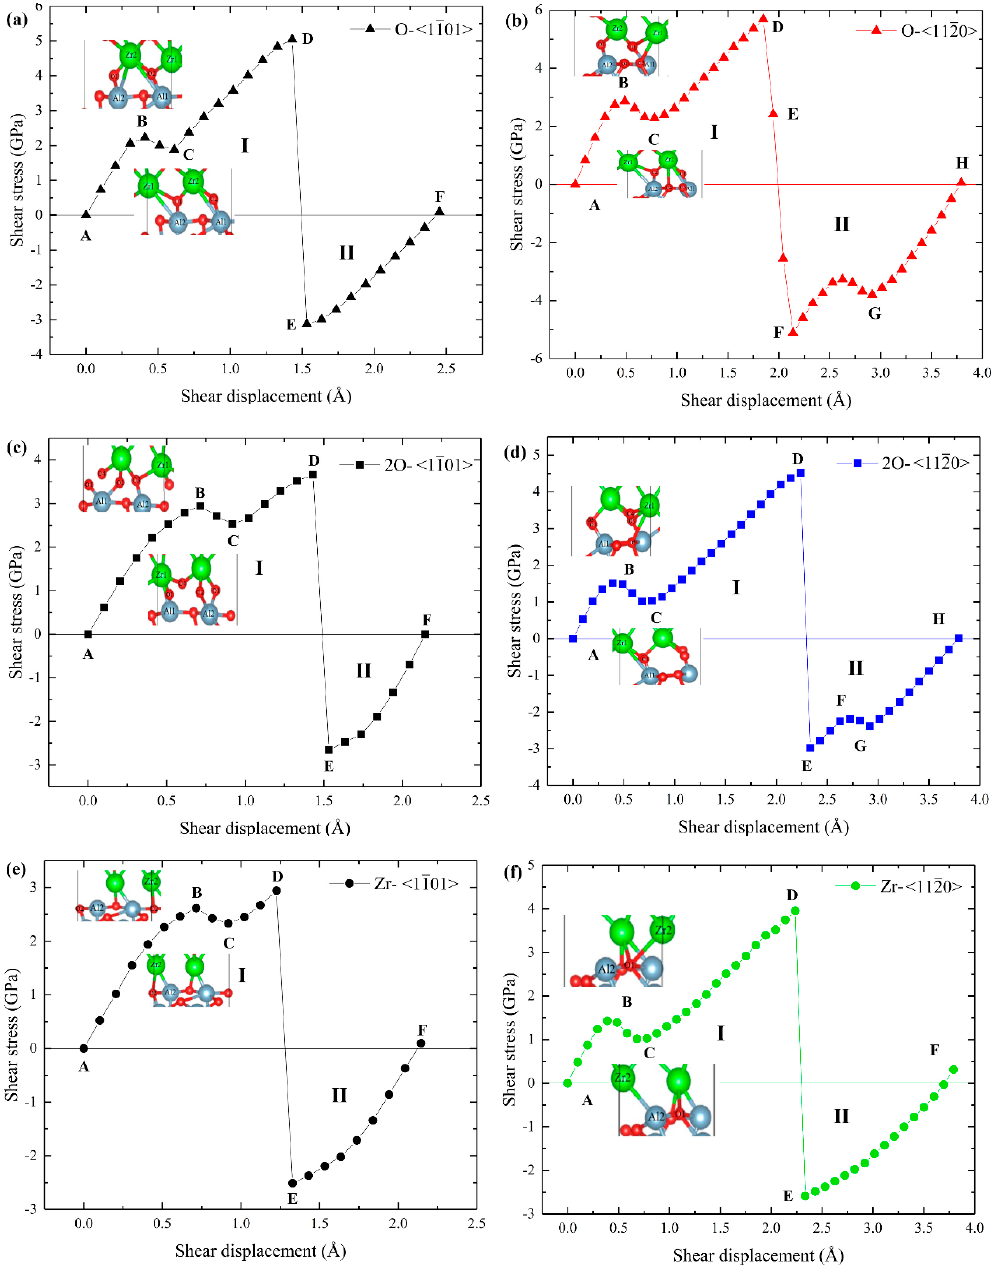
Figure 2. Shear stress–displacement curves of the c-ZrO 2 (001)/ α -Al 2 O 3 (11 (cid:3364) 02) interface models: ( a ) O-<11 (cid:3364) 01>, ( b ) O-<112 (cid:3364) 0>, ( c ) 2O-<11 (cid:3364) 01>, ( d ) 2O-<112 (cid:3364) 0>, ( e ) Zr-<11 (cid:3364) 01>, and ( f ) Zr-<112 (cid:3364) 0>. The horizontal lines are the boundaries between region I and II. The shear stresses in region I are positive values, instead those in region II are negative. Specific Zr-O and Zr-Al bonds are also depicted at certain stages.